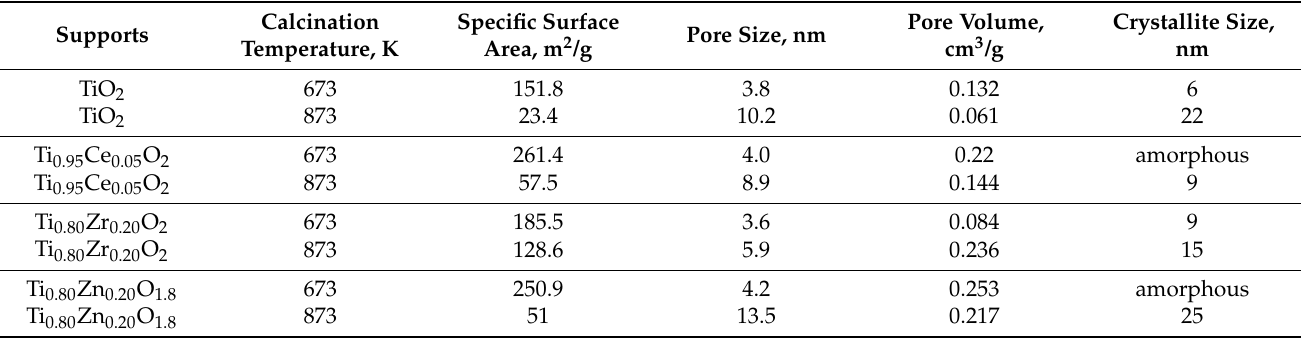
Figure 3. TEM and HRTEM (inserted) micrographs of the powdered catalysts ( A ) PdZn/TiO 2 -H-573, ( B ) PdZn/Ti 0.8 Zr 0.2 O 2 -H-573, ( C ) PdZn/Ti 0.95 Ce 0.05 O 2 -H-773, ( D ) PdZn/Ti 0.8 Zn 0.2 O 1.8 -H-573. Table 1. Physicochemical properties of Ti x M 1 − x O y (M = Zr, Ce, Zn) mesoporous supports obtained by varying the calcination